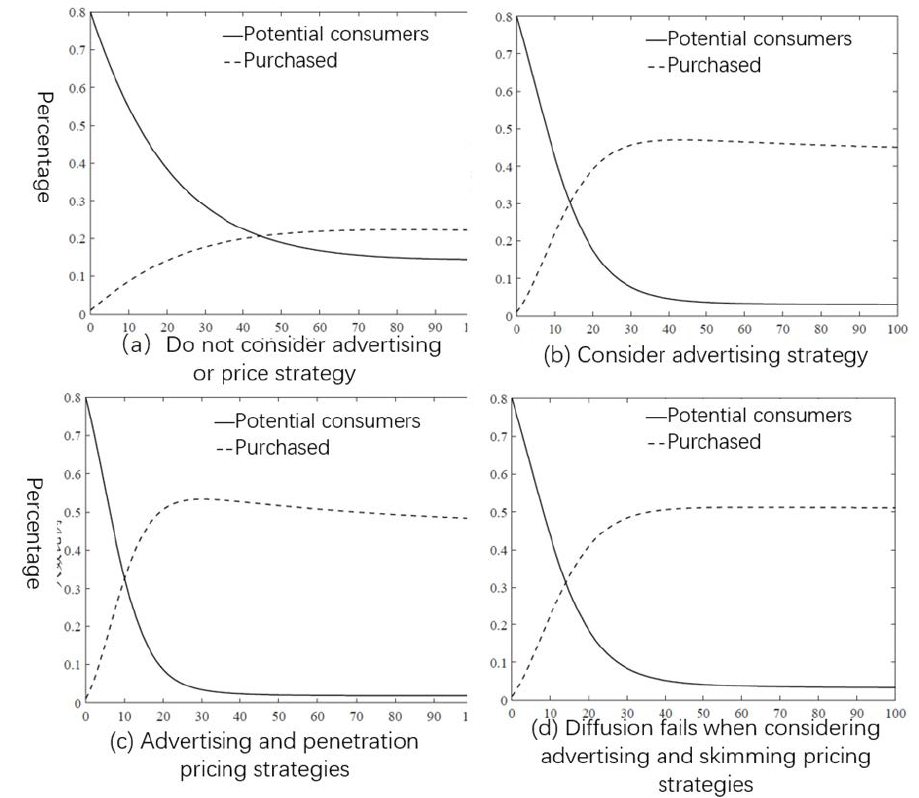
Fig. 2 Consumer behaviour under different